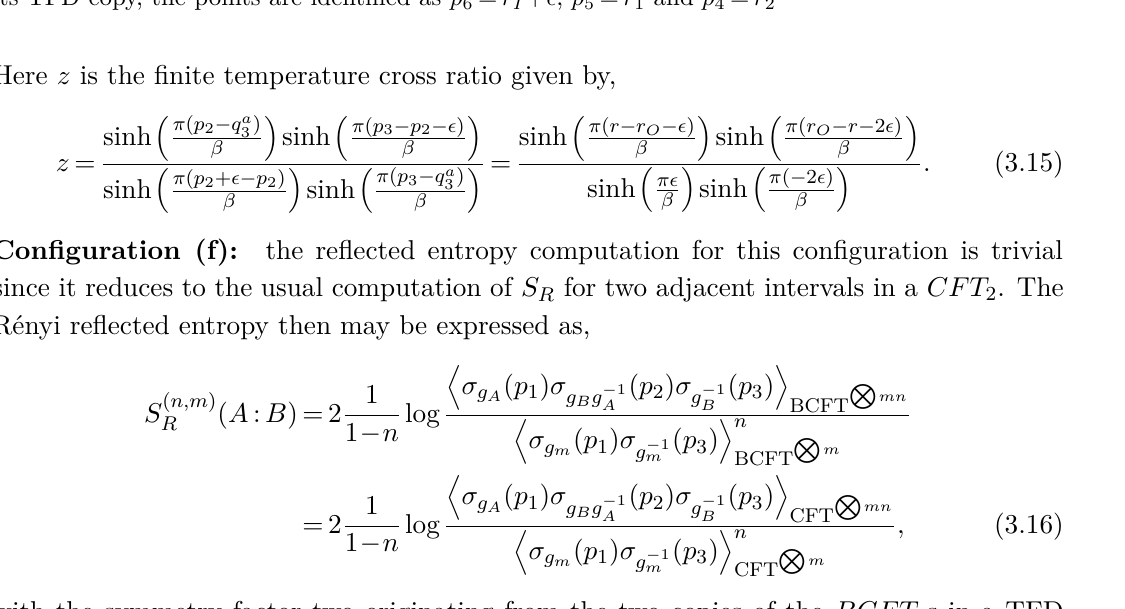
Figure 8 . Possible channel for the S R when the interval sizes are small compared to the full bath BCFT 2 s. The points in the diagram are specified as p 1 = r I + (cid:15) , p 2 = r 1 and p 3 = r 2 . Similarly in its TFD copy, the points are identified as p 6 = r I + (cid:15) , p 5 = r 1 and p 4 = r